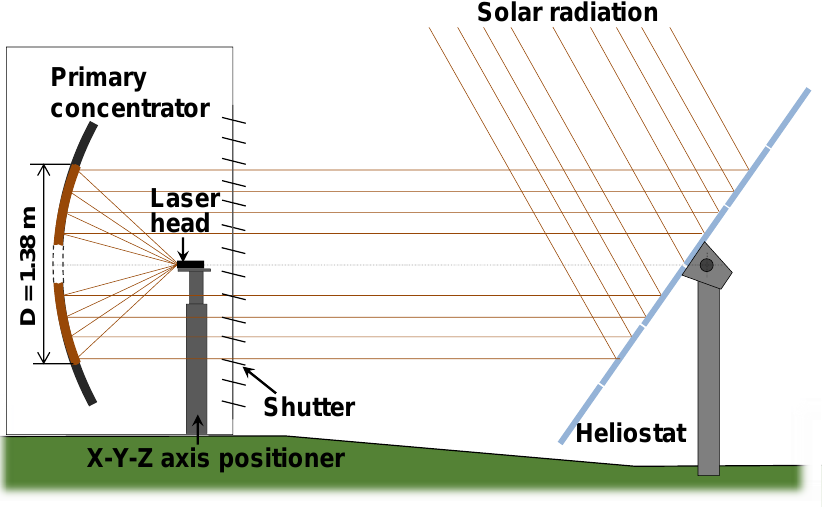
Figure 3. Schematics of the PROMES-CNRS solar energy collection and concentration system.